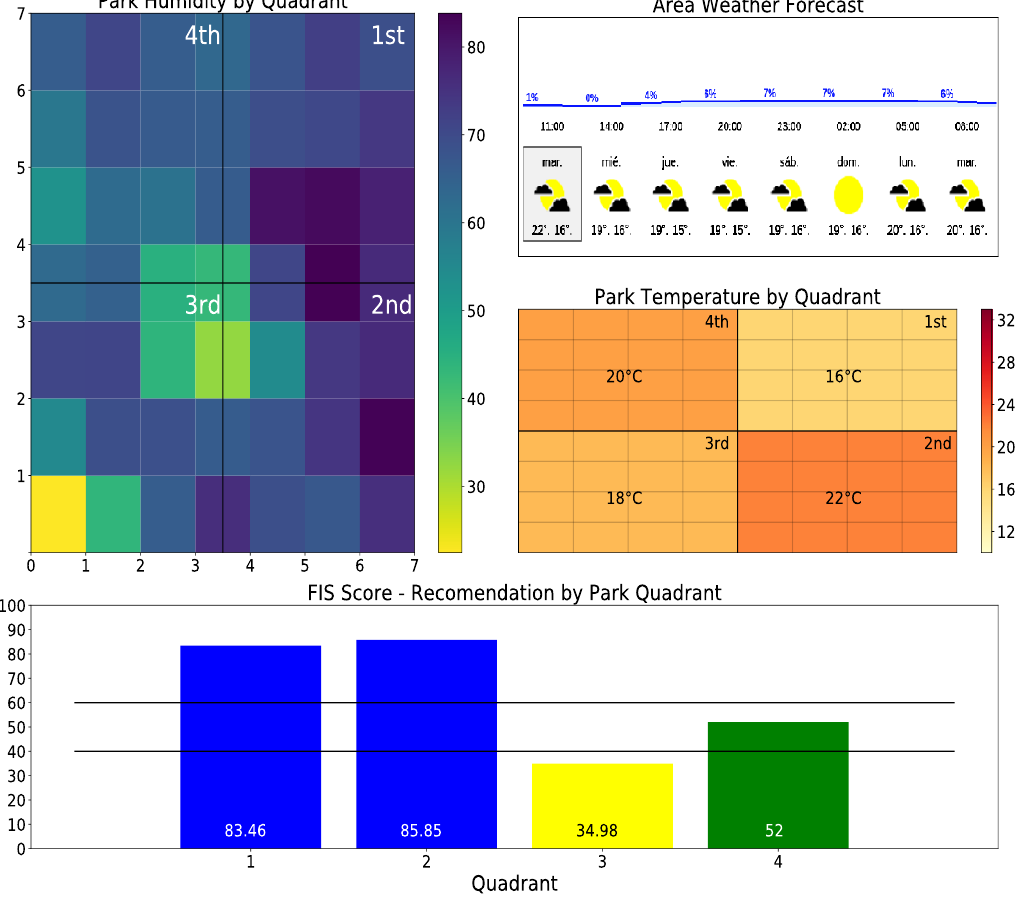
Figure 3. Proposed